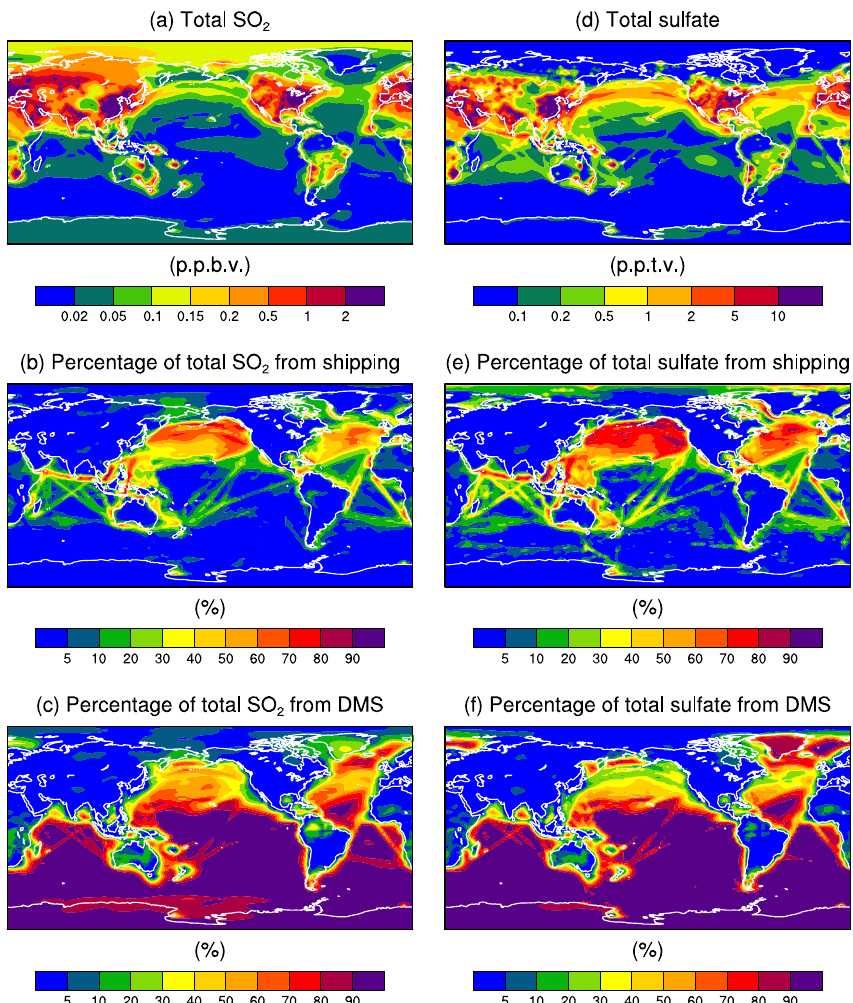
Figure 2. Spatial patterns of (a) annual mean concentrations of total SO 2 (parts per billion by volume; ppbv). Panels (b, c) show, respectively, the contributions of shipping emissions and natural DMS to total SO 2 in the lowest model layer. Panels (d) – (f) are the same as (a) – (c) , but for sulfate aerosols. These results are from MARC simulations and calculated as the differences between the simulations with the international shipping and DMS emissions at the reference and zero levels (i.e., ShipRef_DMSRef minus ShipZero_DMSRef and ShipRef_DMSRef minus